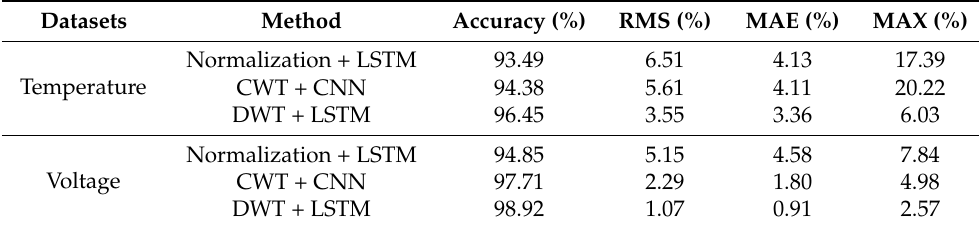
Table 4. Comparison of battery SOH estimation performance.